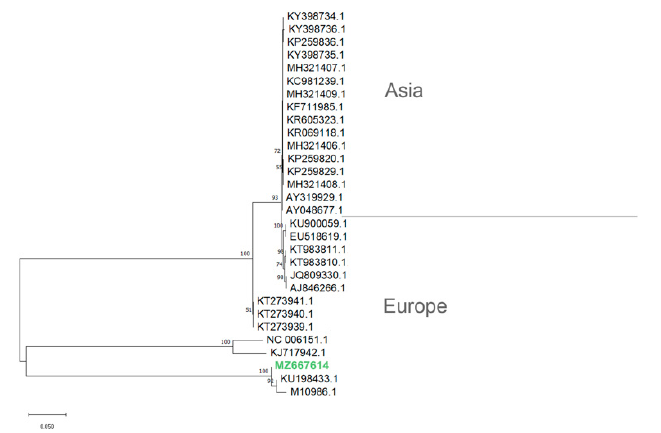
Figure 5. Phylogenetic tree (NJ) depicting relationships among the PrV isolates based on glycoprotein G genes. Nucleotide sequences were aligned using the ClustalW algorithm, and the evolutionary history was inferred using the Neighbor Joining (NJ) method in MEGA11 (Tamura et al., 2021). Bootstrap values (1000 replicates) are indicated at the nodes. GenBank accessions from PrV strains are as follow (accession/strain): KU198433.1/ADV32751/Italy2014; NC_006151.1/, KJ717942.1/